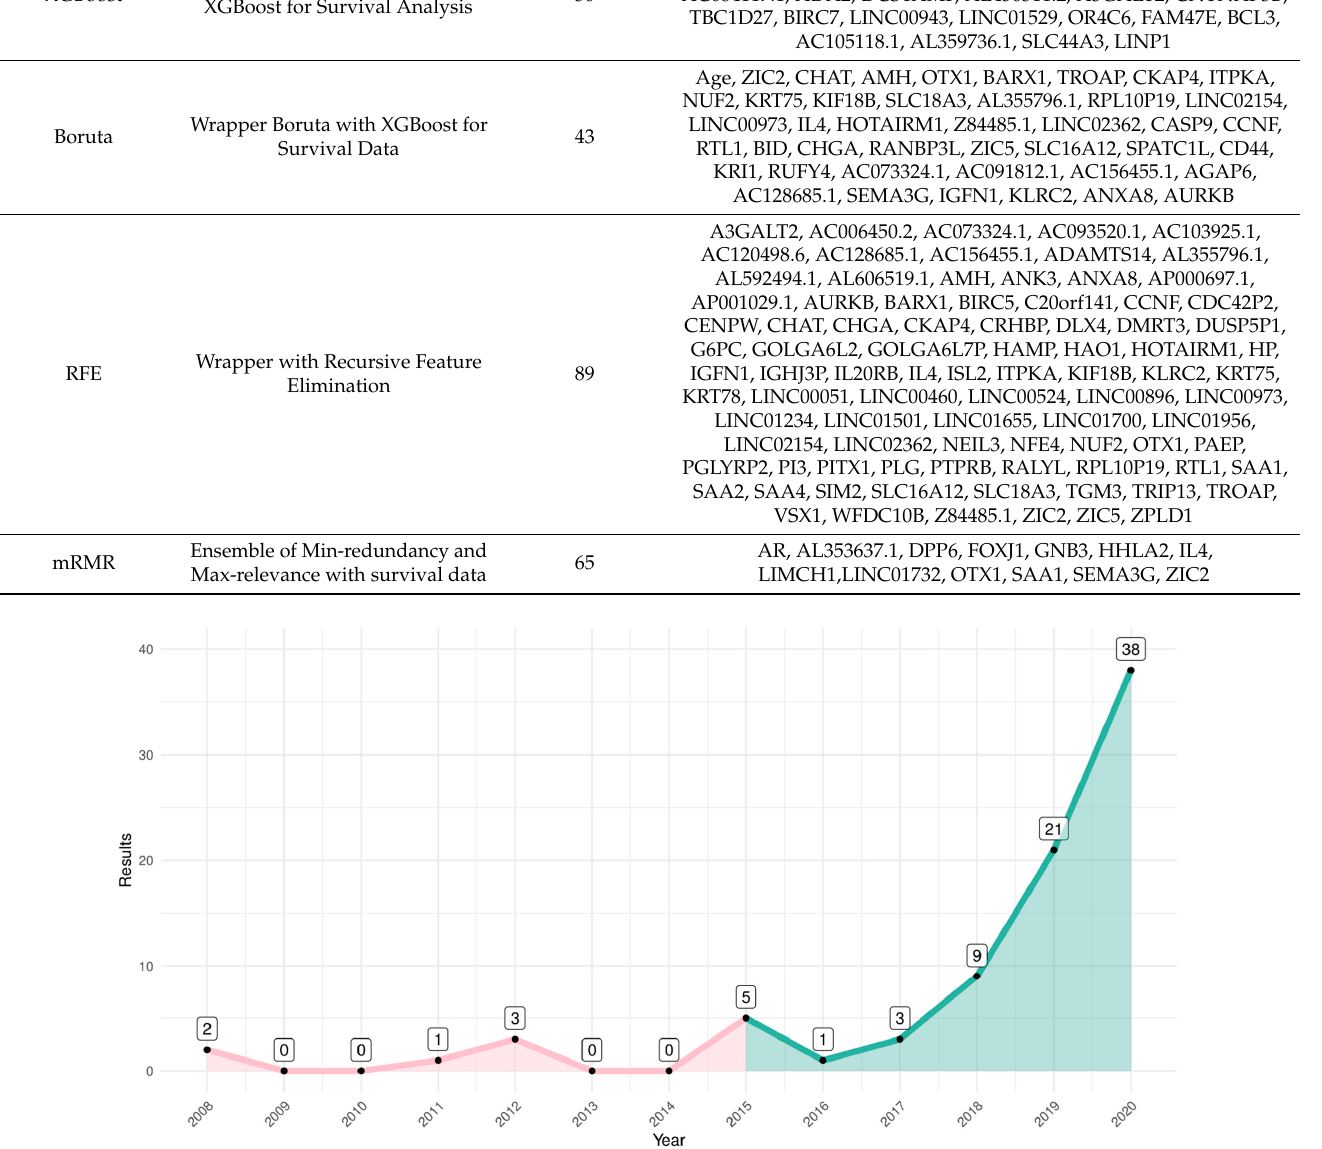
Figure A1. Number of papers published on PubMed by year on query performed in January 2021. Initially, in green, the gene signatures published in the period of 2015 to 2020 were selected to be compared. After the exclusion criteria, we obtained the 14 gene signatures.